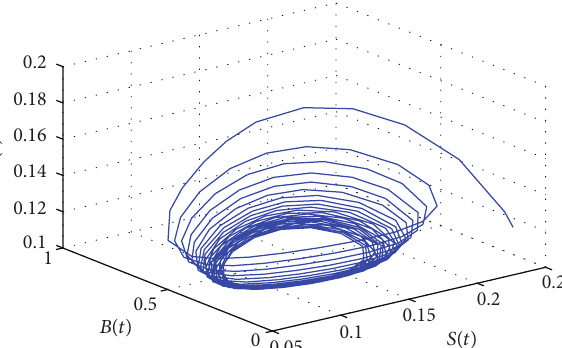
Figure 3: The phase plot of states 𝑆 , 𝐿 , and 𝐵 for 𝜏 = 60.5386 > 𝜏 0 = 58.5472 .